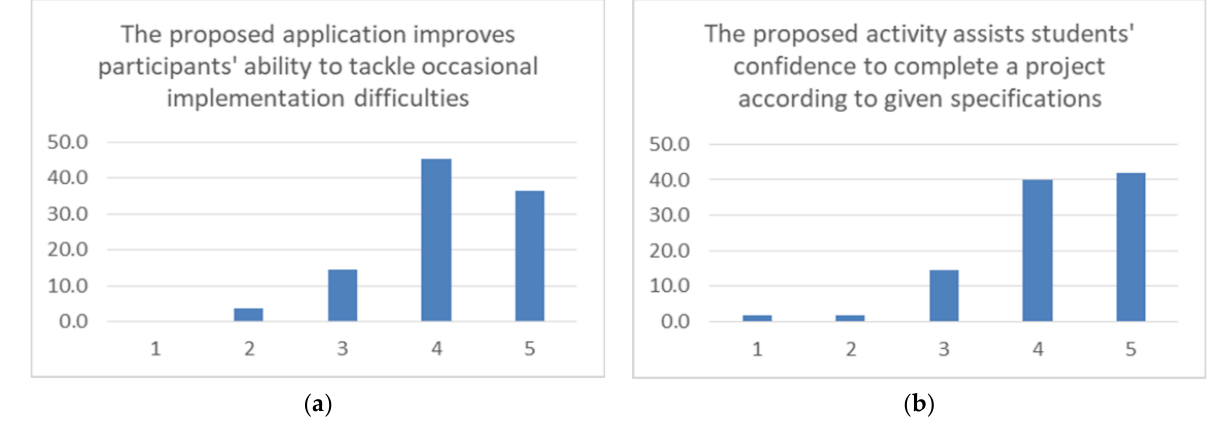
Figure 17. Participants’ opinions about the degree to which the proposed activity improves: ( a ) the ability to tackle and exploit occasional implementation difficulties; ( b ) the confidence to complete a project according to the given specifications.